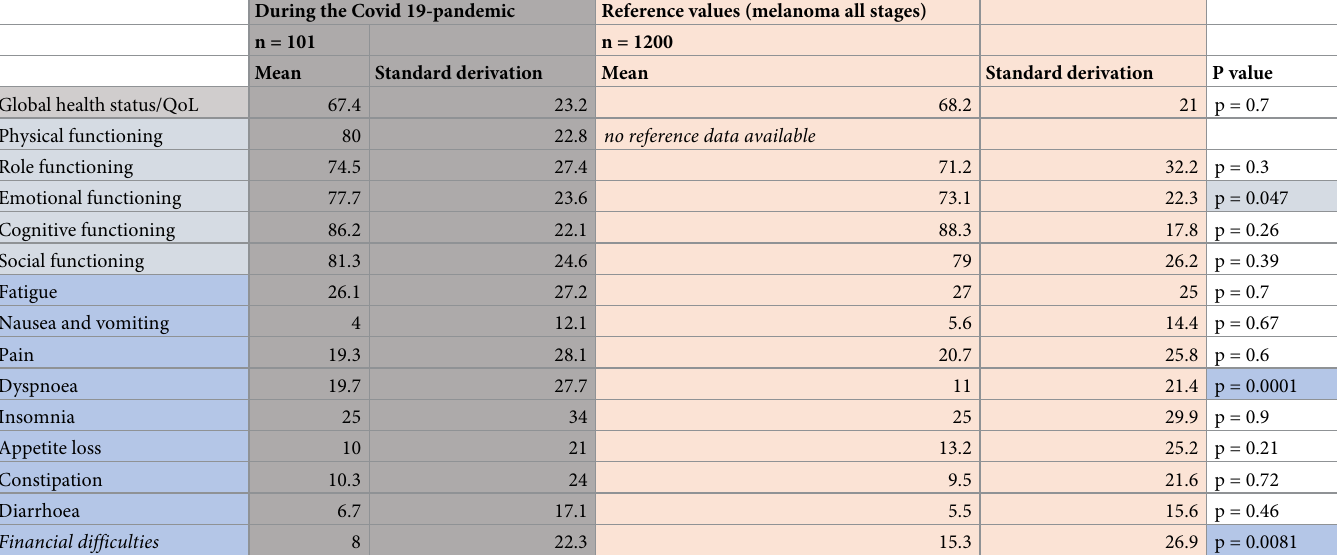
Table 4. EORTC quality of life questionnaire—C30 in comparison to reference values "melanoma/all stages". During the Covid